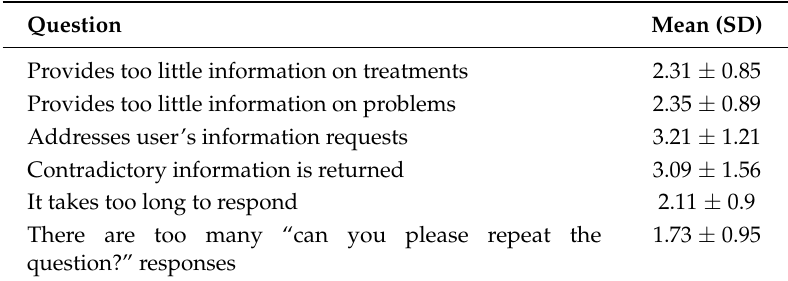
Table 2. Example questionnaire